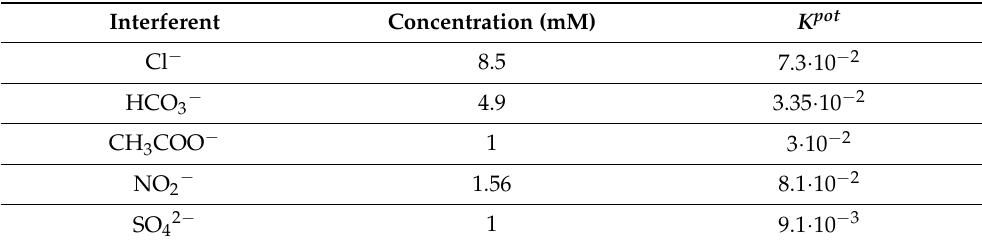
Table 2. Quantification of the interfering effect of different anions on the response of the NO 3 − sensor. The compositions on which each study was performed are included.